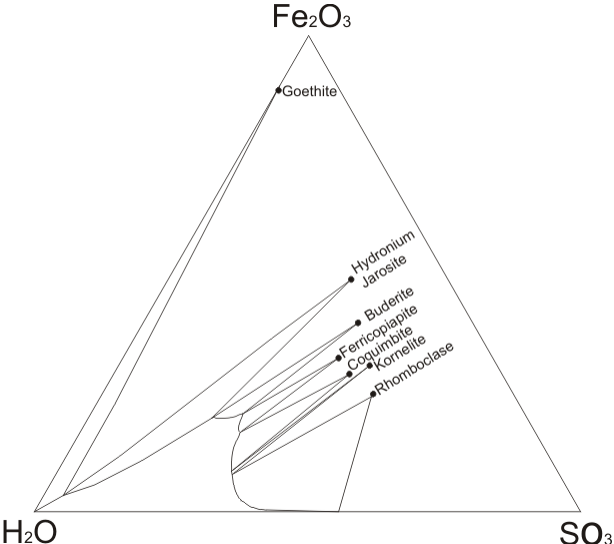
O -SO -H O system at 30–40 2 3 3 2